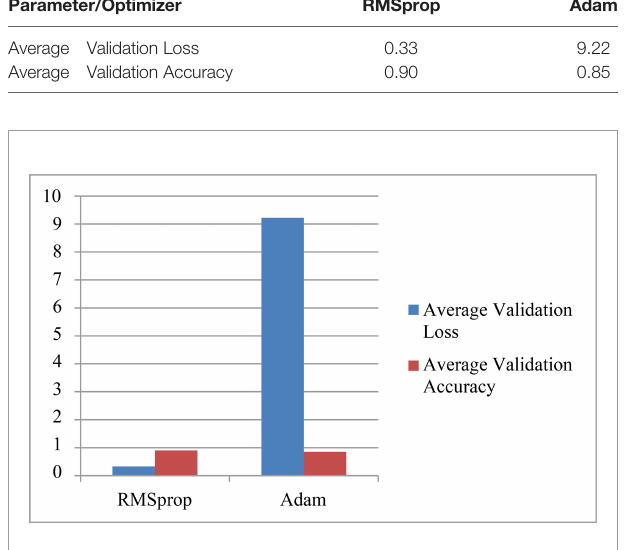
TABLE 3 | Comparison of the proposed work with existing